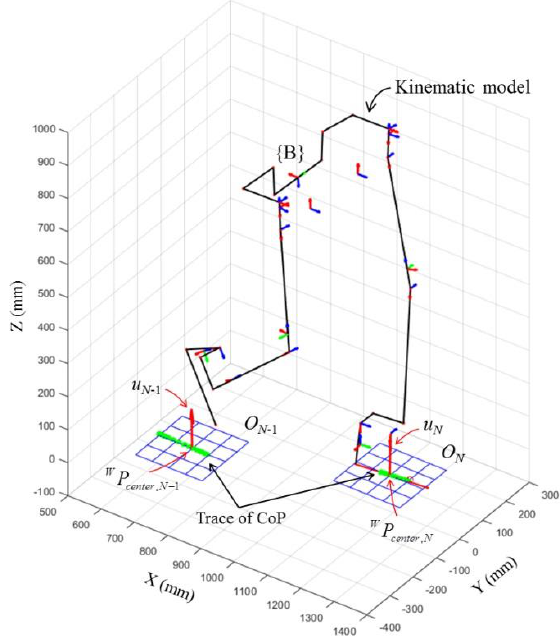
Figure 19. Result of contact surface estimation for both feet during walking.